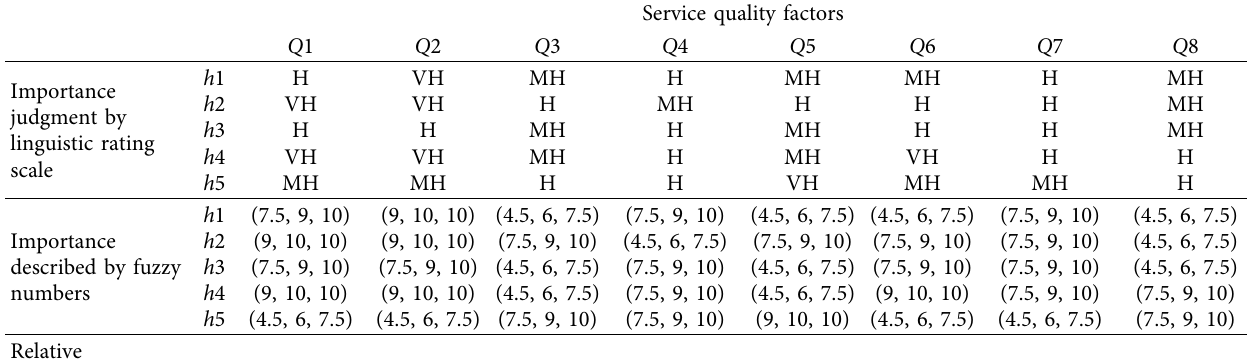
Table 11: Customer scoring information on the relative importance of the 8 service quality indicators.